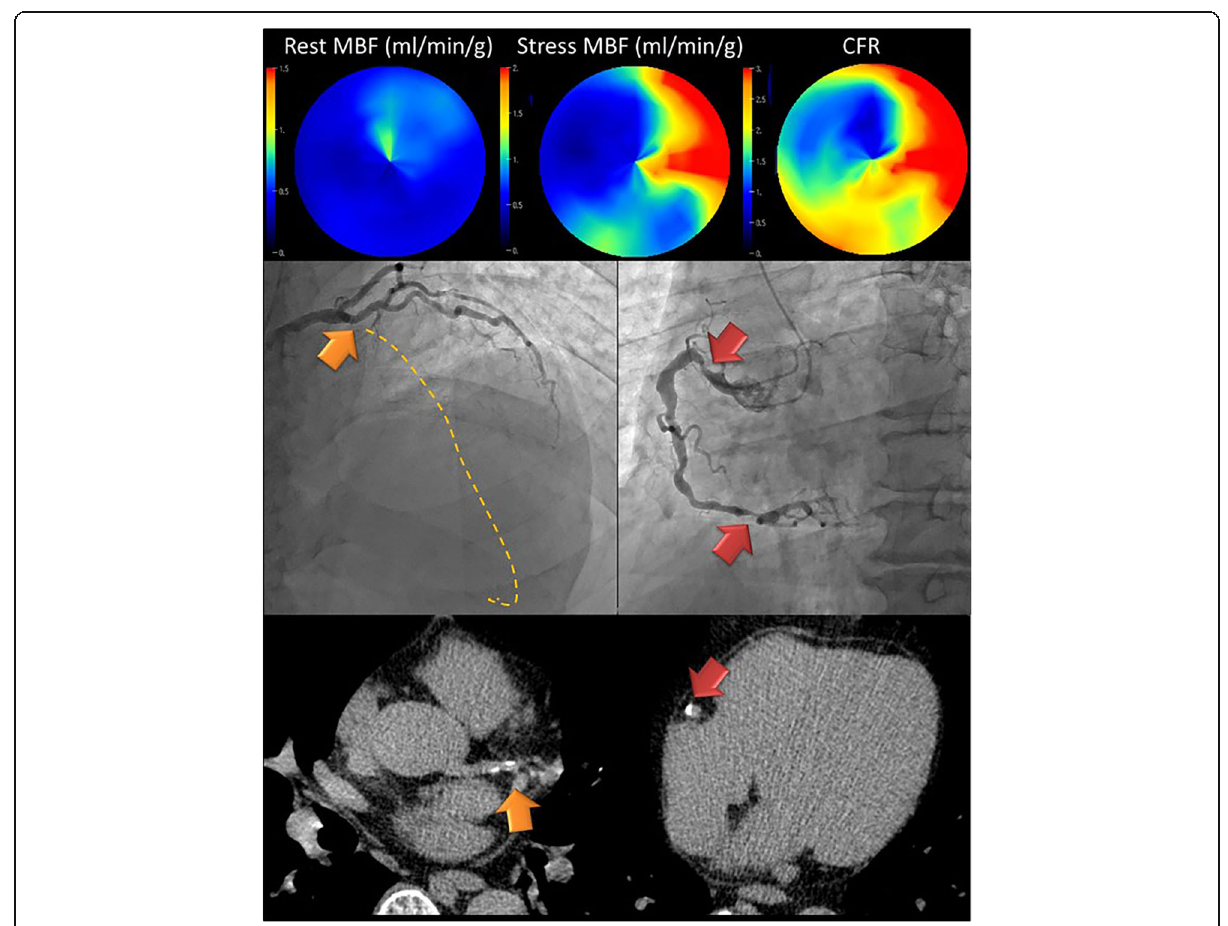
Fig. 4 Representative CAD case: A man in his 60s who had significant stenosis in the LAD (#6 100%; orange arrow ) and RCA (#1 70%, #3 90%; red arrows ). 15 O-water PET/CT demonstrated the decrease of stress MBF and CFR in the LAD and RCA territories. The estimated whole CFR was 2.19. The CFRs in the LAD, LCX, and RCA territory were 1.66, 3.11, and 2.01, respectively. Calcifications were seen on the LAD and RCA (Agatston